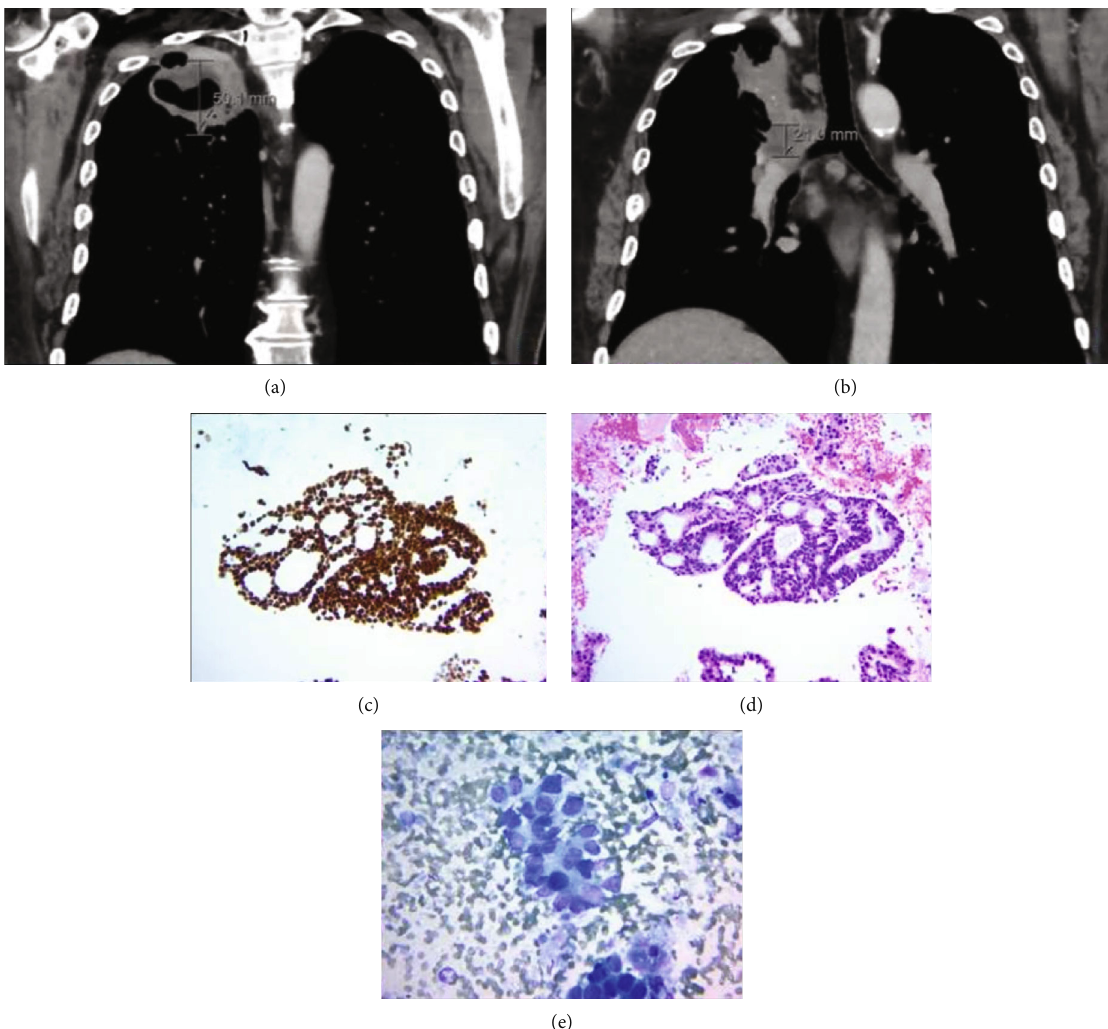
Figure 2: (a) Right upper lobe cavitary pulmonary lesion measuring up to 6 : 0 × 6 : 3 × 5 : 0cm ; (b) right superior hilar/mediastinal heterogeneously enhancing mass measuring up to 3 : 7 × 4 : 8 × 2 : 1cm ; (c) smear (Di ff -Quik-stained slide, 400 × magnification ) showing cohesive malignant cells characterized by enlarged nuclei with pleomorphism and moderate cytoplasm, consistent with metastatic non- small-cell carcinoma; (d) cell block (H&E stain, 200 × magnification ) showing tumor cells that are arranged in a cribriforming growth pattern consistent with metastatic adenocarcinoma. This growth pattern has been associated with aggressive behavior; (e) immunohistochemical stain ( TTF − 1, 200 × magnification ) shows that the tumor cells are strongly and di ff usely positive for TTF-1 (nuclear staining). This supports the diagnosis of metastasis from a lung primary (in the setting of a lung